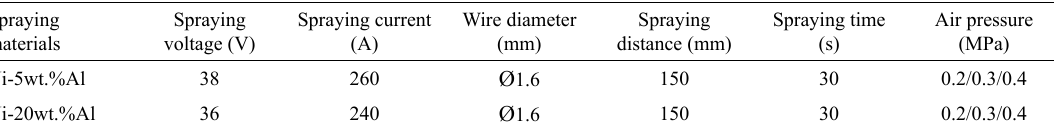
Table 3. Processing parameters of obtaining Ni-Al powder.